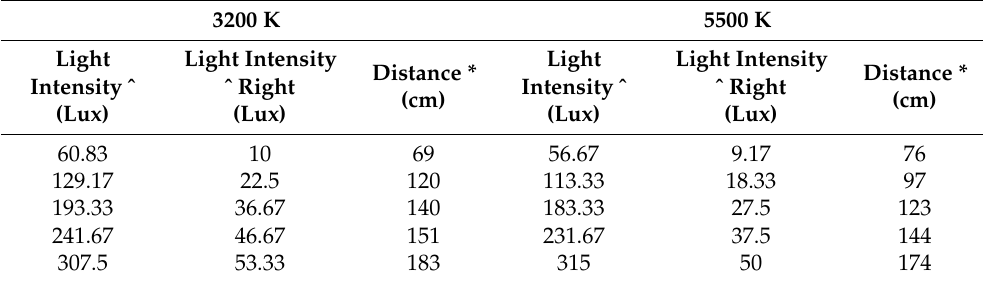
Table 3. Compare the relation among light intensity (Lux), light color (Kelvin), and detection distance (cm) for light source with diffuser from right